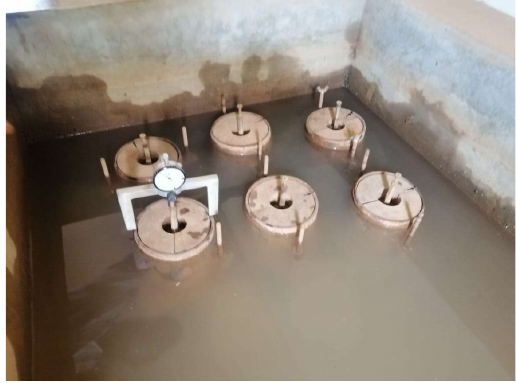
Figure 4. CBR swell tripod for measuring